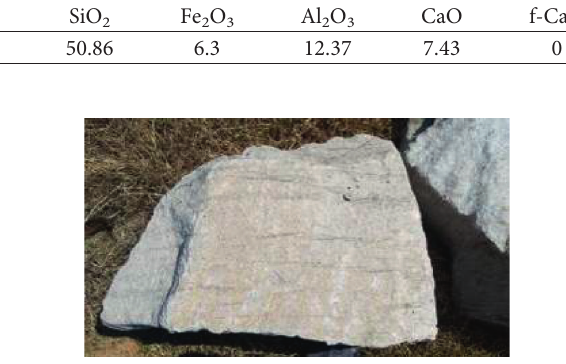
Figure 1: Undisturbed coal gangue.